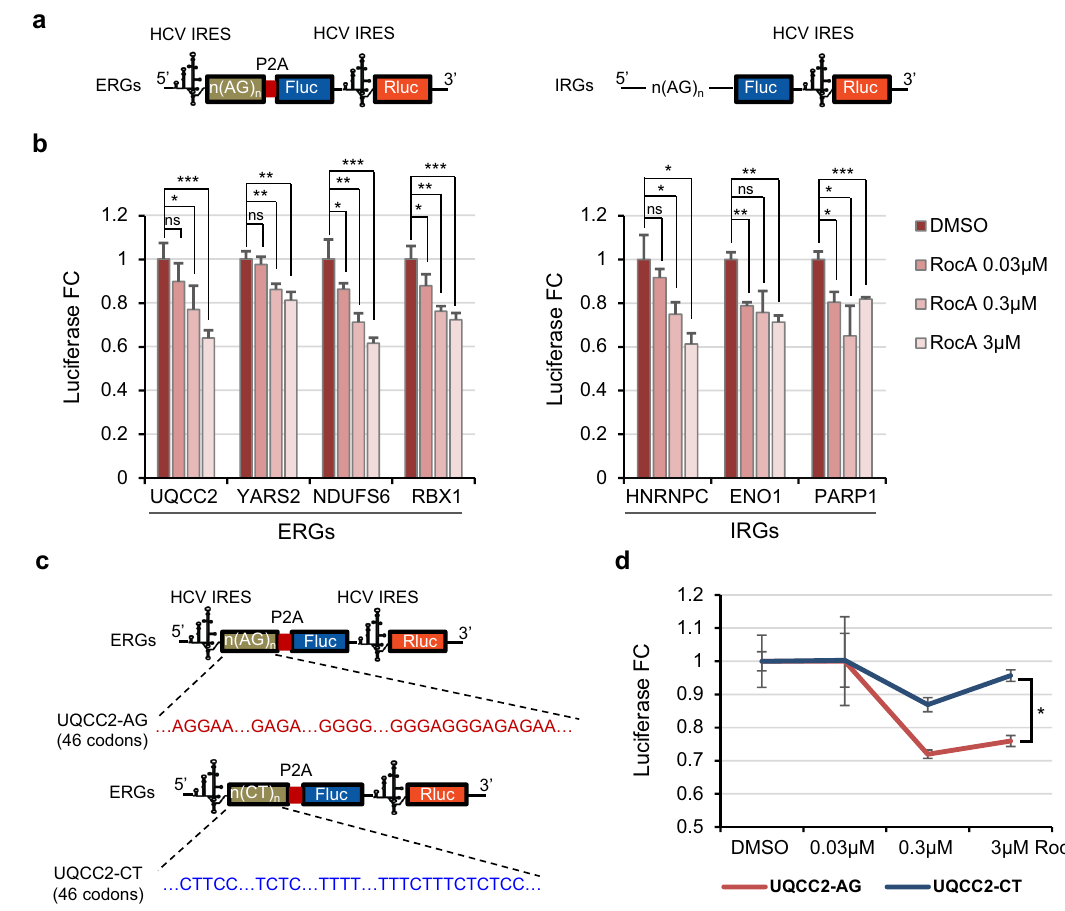
Fig. 5 | Luciferase reporter assays showing reduced protein synthesis due to blockage of translation elongation upon RocA treatment. a Structures of dual- luciferase reporters with poly-purine sequences obtained from upstream CDSs of ERGs or 5 ′ UTRs of IRGs. HCV-like IRES was used for cap-independent translation initiation. b Fire fl y luciferase activities in relative to Renilla luciferase after trans- fectionsofdifferentconstructs,followedby30minofRocAtreatmentsatdifferent doses. c Design of the reporterconstructs forrescue experiments by replacing the